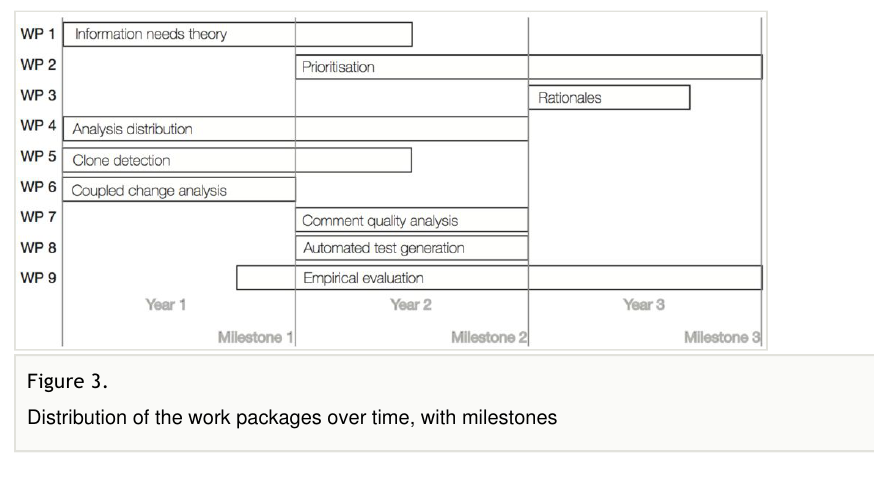
The milestones and success criteria for all three years are summarised in Table 1.